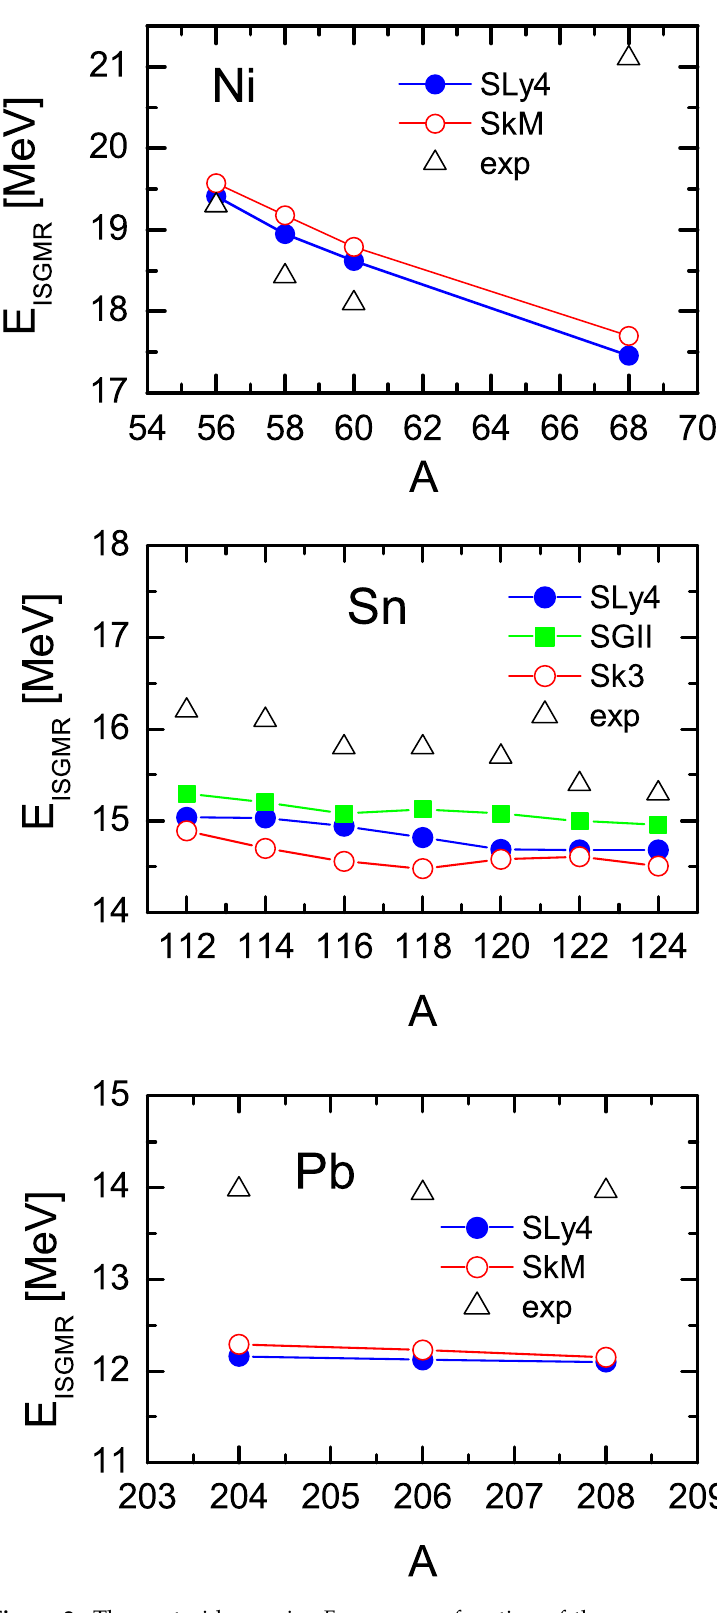
Figure 2. The centroid energies E ISGMR as a function of the mass number A for Ni, Sn, and Pb isotopes in the cases of SLy4, SGII, Sk3, and SkM forces and r 0 = 1.2 fm (Equation (1)) compared with the experimental